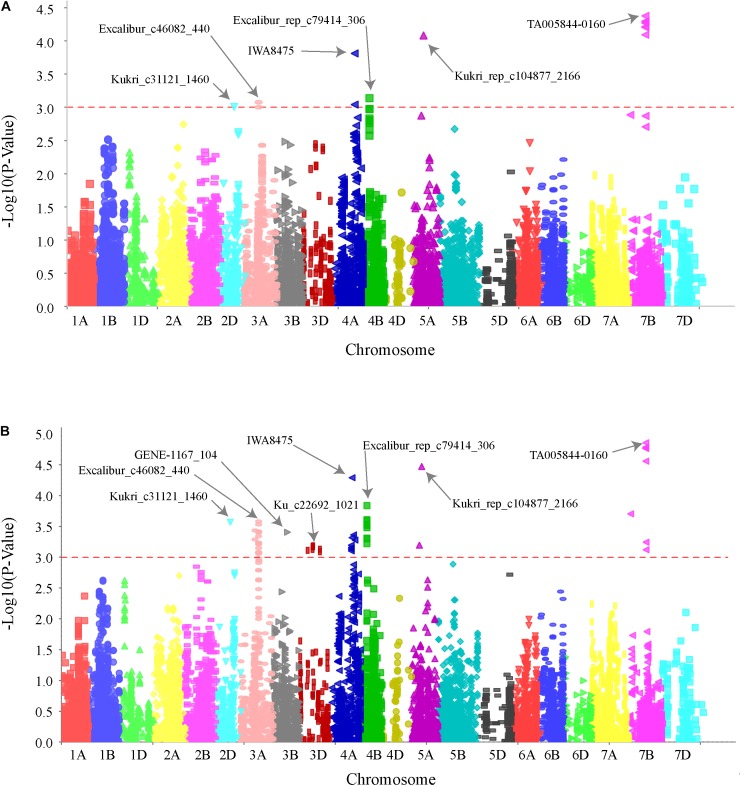
Genome wide association scan for SB resistance in hard winter wheat association mapping panel (HWWAMP). Manhattan plot developed using mixed linear model (MLM) (A) and general linear model (GLM) (B) in TASSEL v.5. The -log10 (P) values from a genome-wide scan are plotted against positions on each of the 21 wheat chromosomes. Horizontal lines indicate genome-wide significance thresholds.